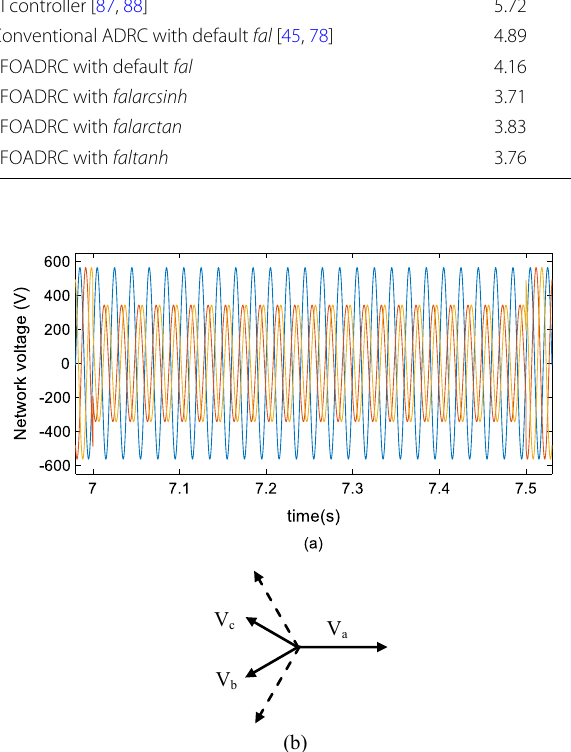
Fig. 32 Unbalance caused by phase-to-phase fault; a three-phase voltages and b phasor diagram